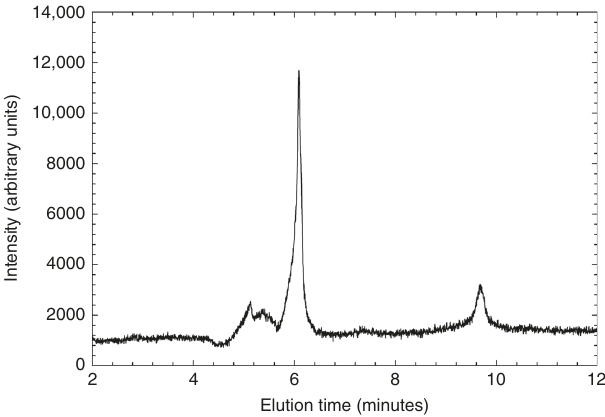
Fig. 1 Chromatogram of phosphorus speciation of sample AKILIA-AK98. m/z + 47 (PO) was observed by ICP – MS. The peak at 6 min matches phosphite and the peak at 9.5 min matches the retention time of phosphate